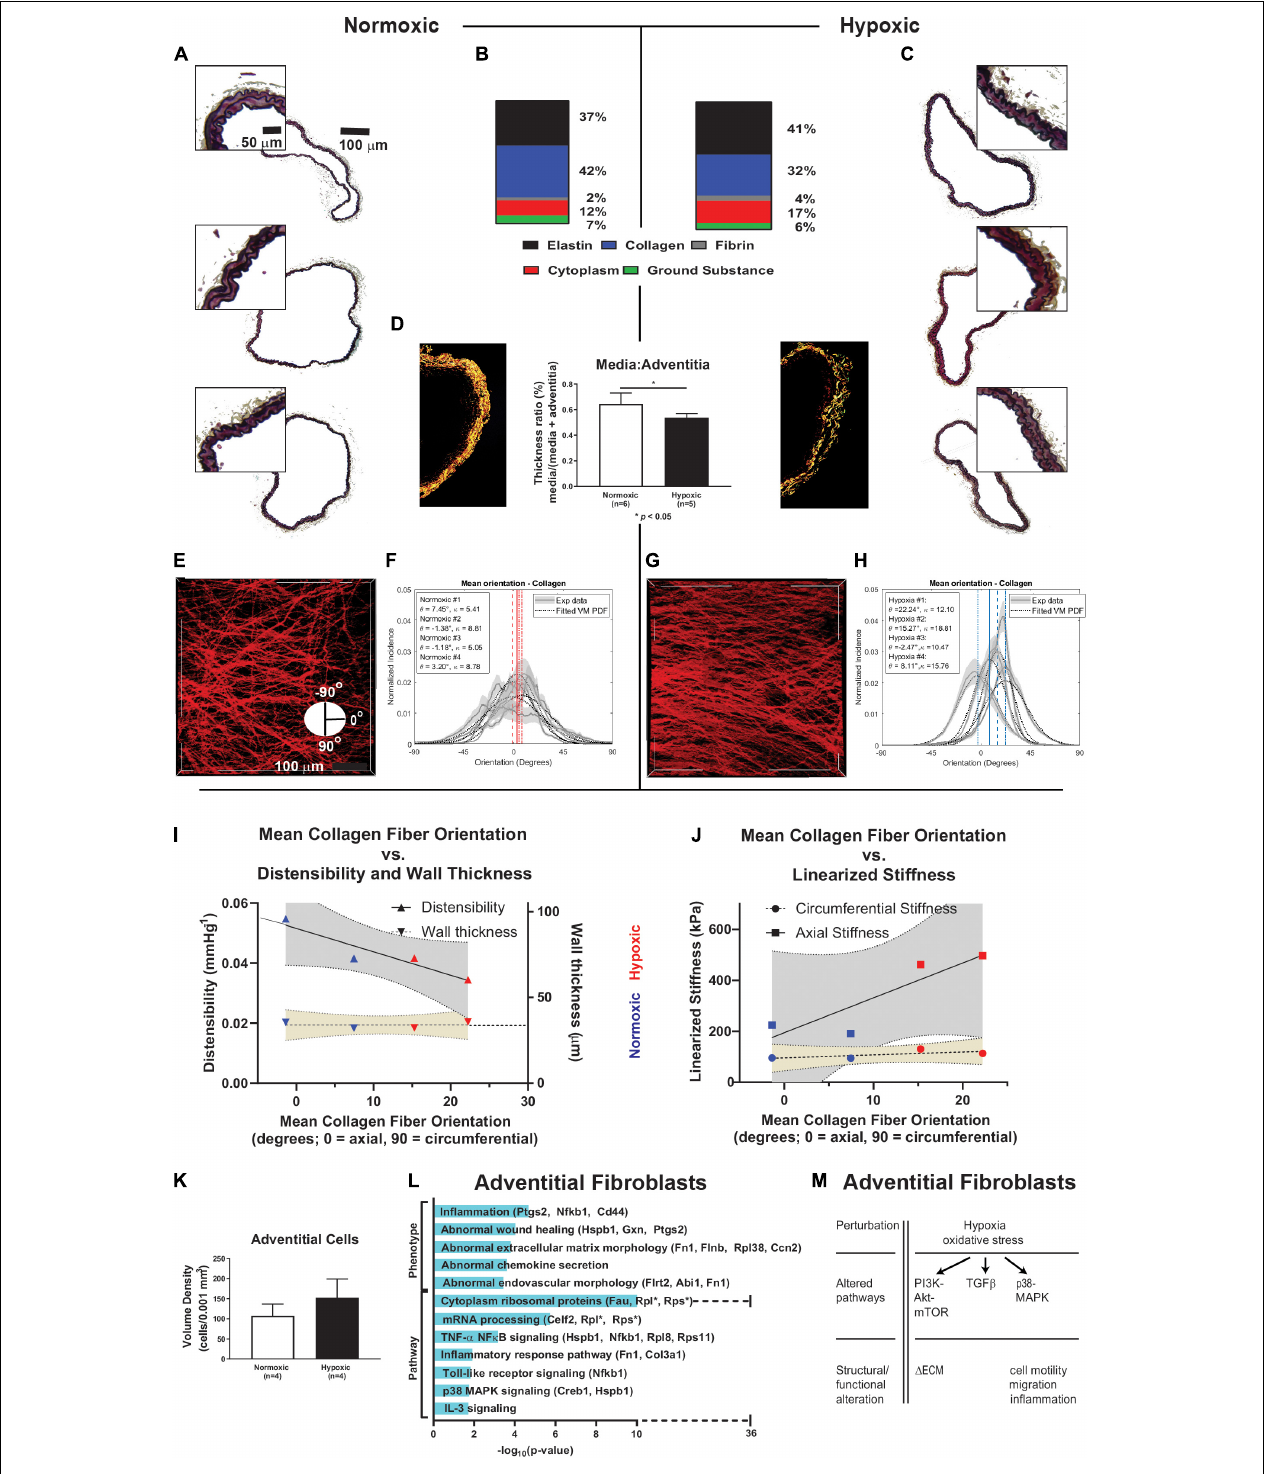
FIGURE 3 | Composition analyses, collagen orientation correlation with stiffness. (A,C) Paraffin embedded, Movat-stained cross-sectional imaging of representative pulmonary arteries from normoxic mice ( n = 3) and hypoxic mice ( n = 3). The complete pulmonary arteries are composite images of 20 × magnification stitched together using Microsoft Image Editor. Small portions of the wall for these samples were enlarged with equal proportion for closer visual examination and comparison. (B) The area fractions for elastin (from VVG), cytoplasm (from MTC), and ground substance and fibrin (from Movat) were computed based on n = 5 samples